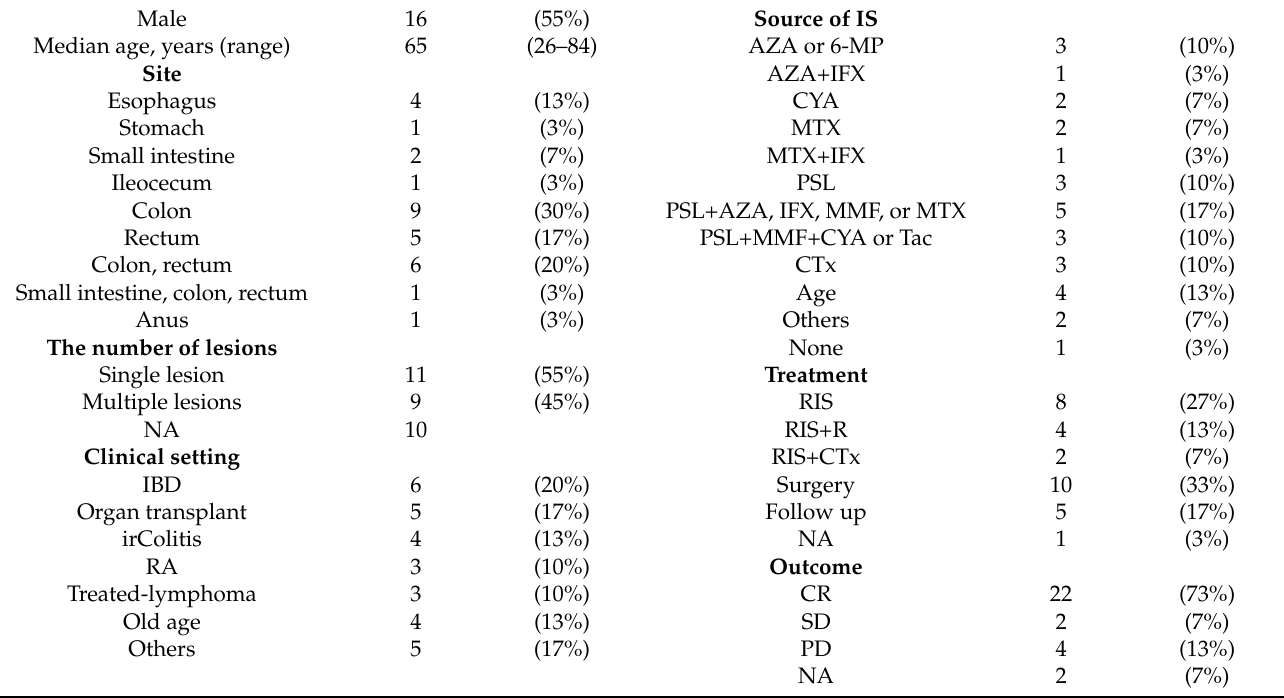
Table 2. Clinicopathological features of 30 cases with EBVMCU of the GI